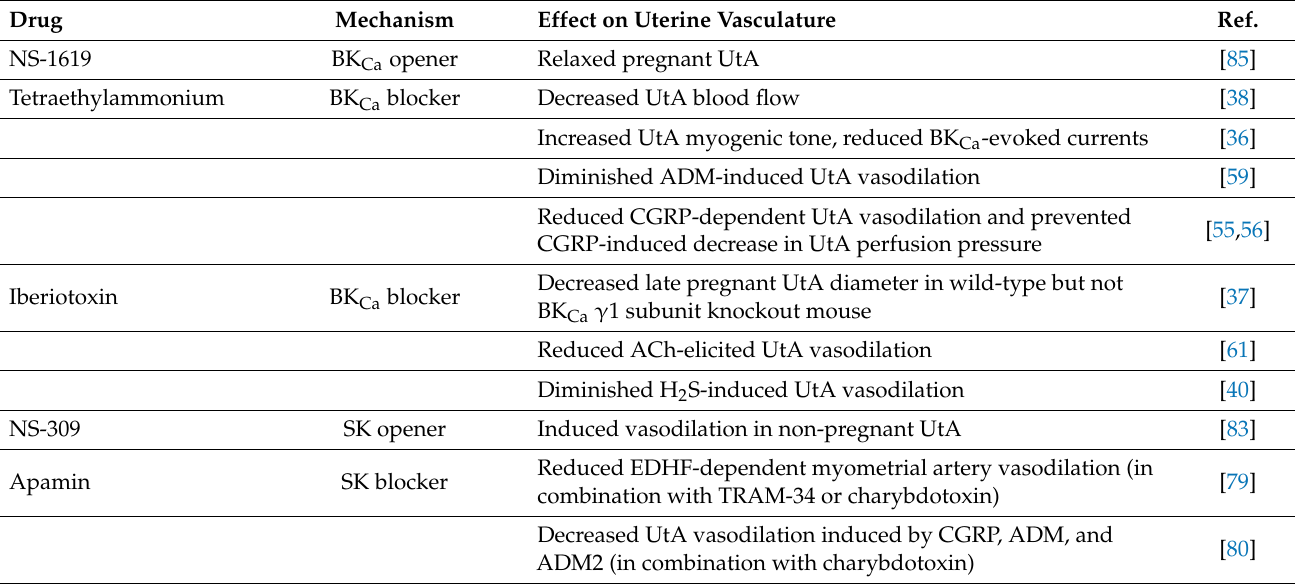
Table 1. K + channel openers and blockers, and their effect on uterine vasculature. Drug Mechanism Effect on Uterine